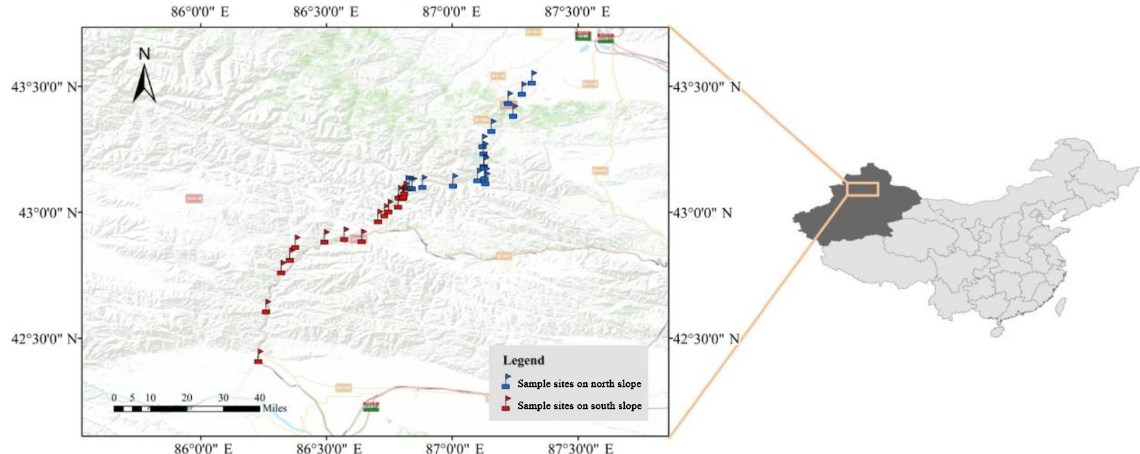
Figure 1. Sketch of study area. Locations of the sampling sites are indicated with points. A total of 17 sites (blue dots) were selected on the north slope, and 16 sites (red dots) were selected on the south